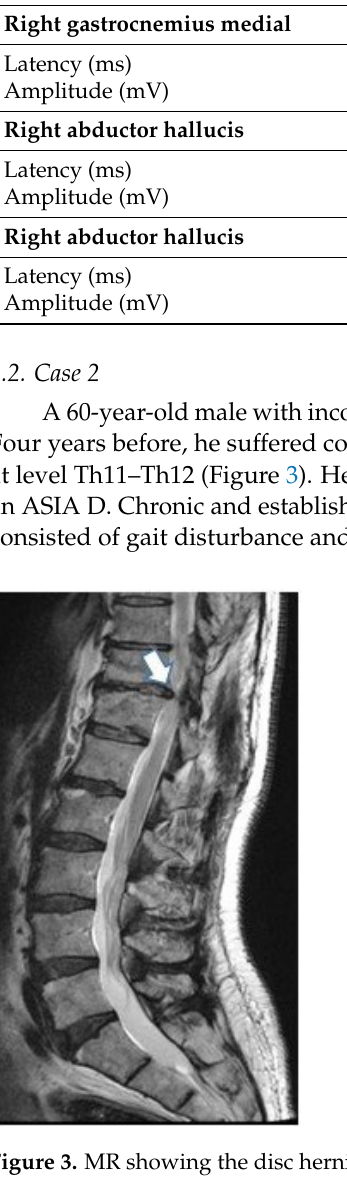
Table 1. Mean values of the motor responses obtained after transcranial magnetic stimulation. After cell therapy, improvements in latency and amplitude in motor evoked potentials were